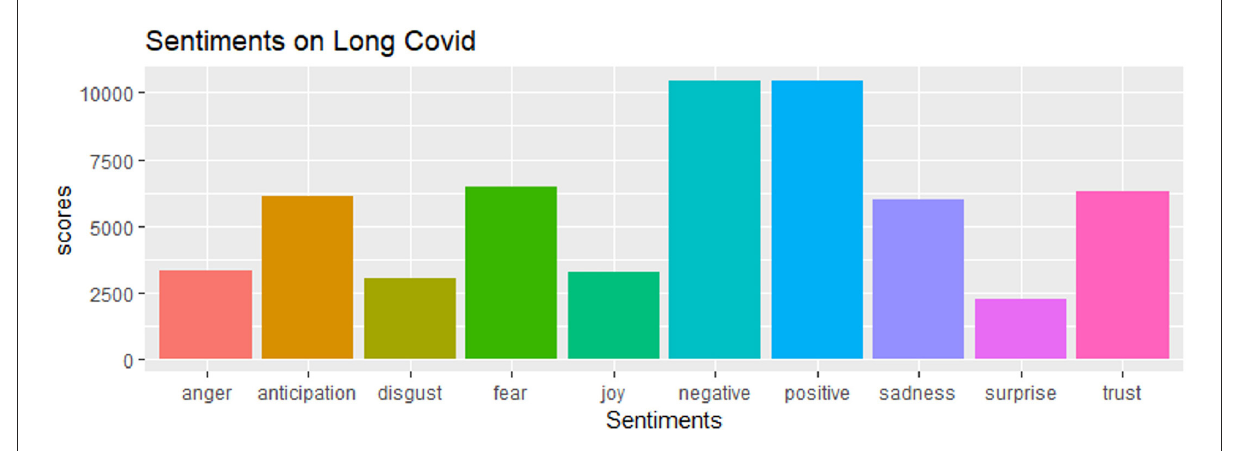
FIGURE10 Sentiment analysis of